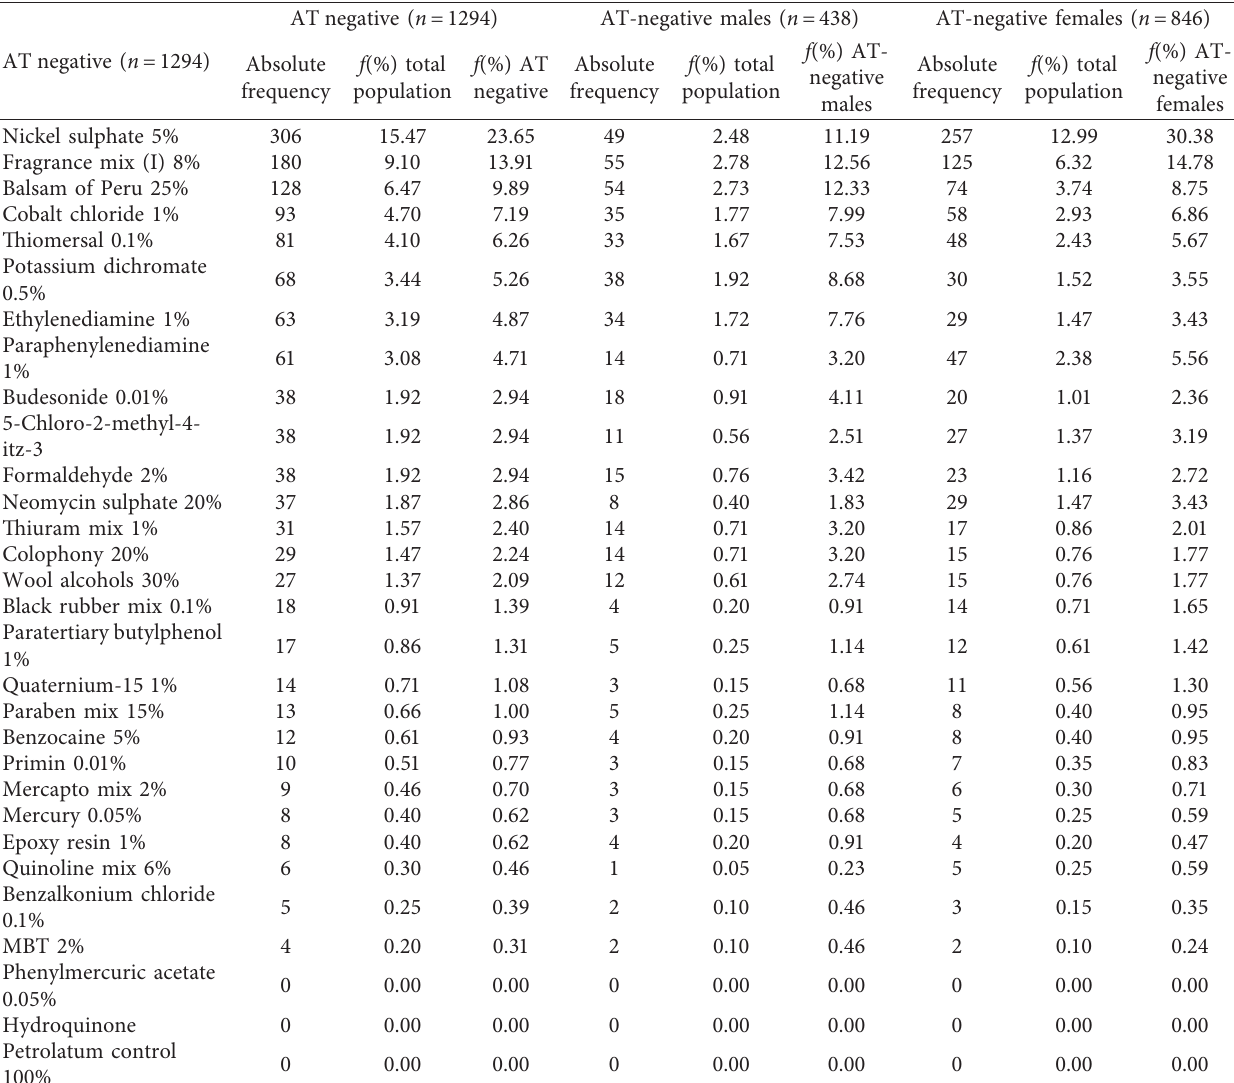
Table 2: Frequencies of the most prevalent allergens in the population without atopic dermatitis (AT), with respect to the total population, as well as the male and female population. AT negative ( n �